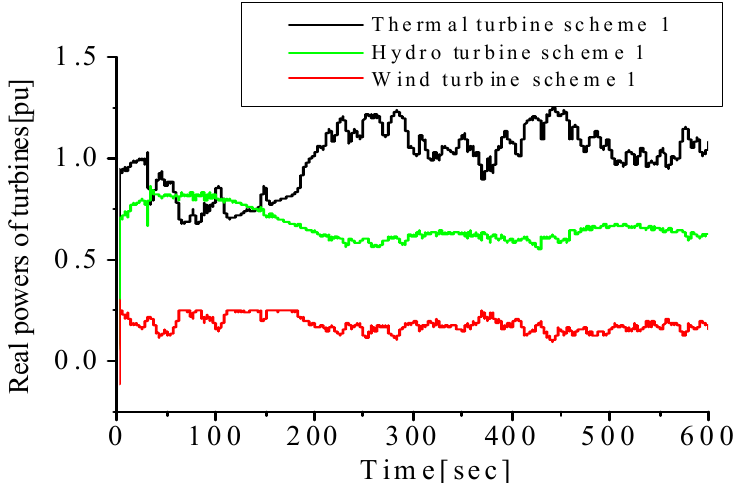
Figure 11. Real powers of turbine using Scheme 1.